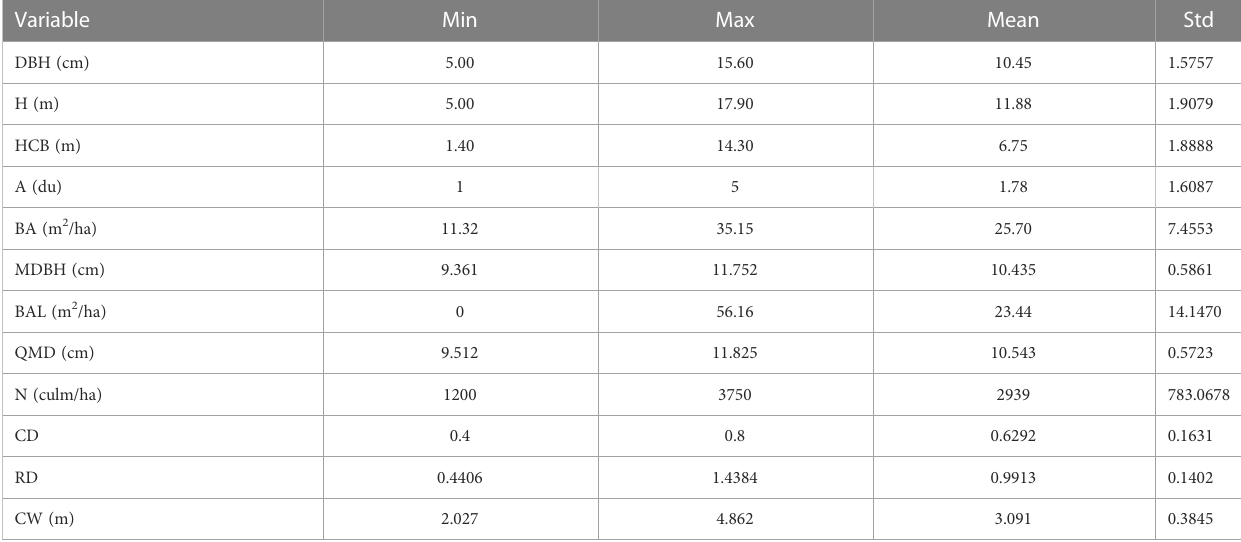
TABLE 2 Summary measurements of bamboo forest characteristics.